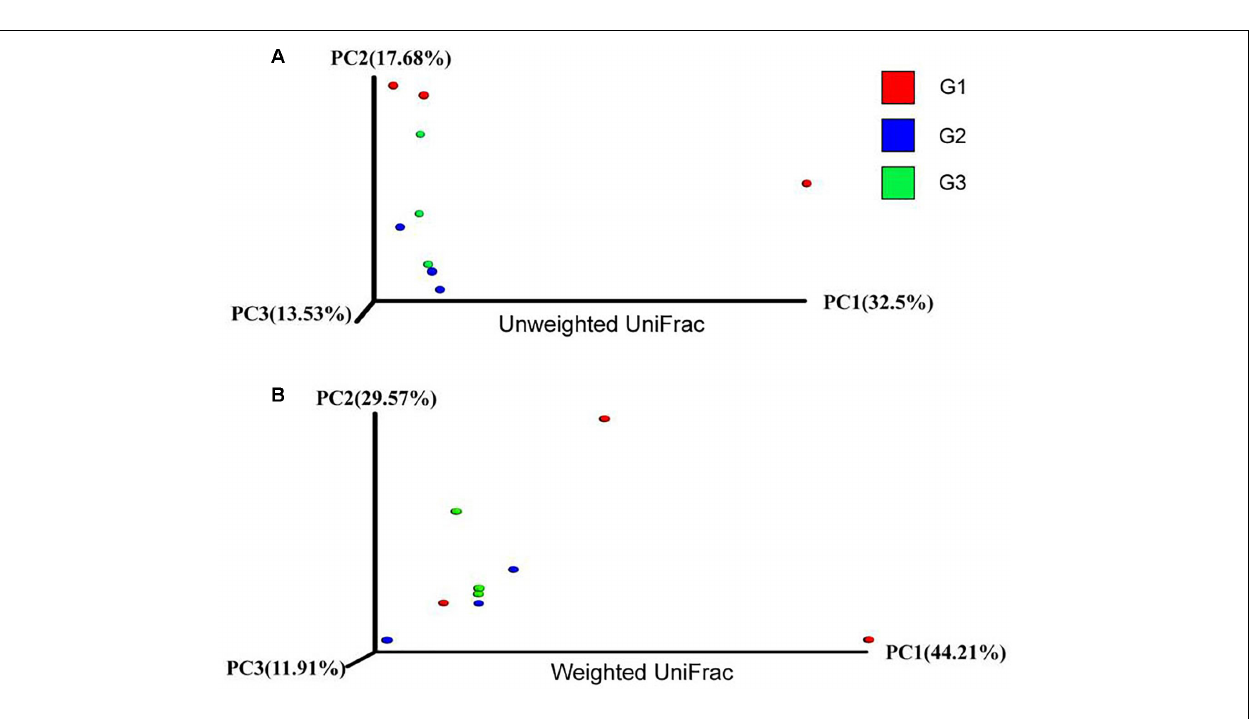
FIGURE 8 | Effects of Ba on β -diversity of microbial population in piglets. Unweight unifrac (A) and weighted unifrac (B) was